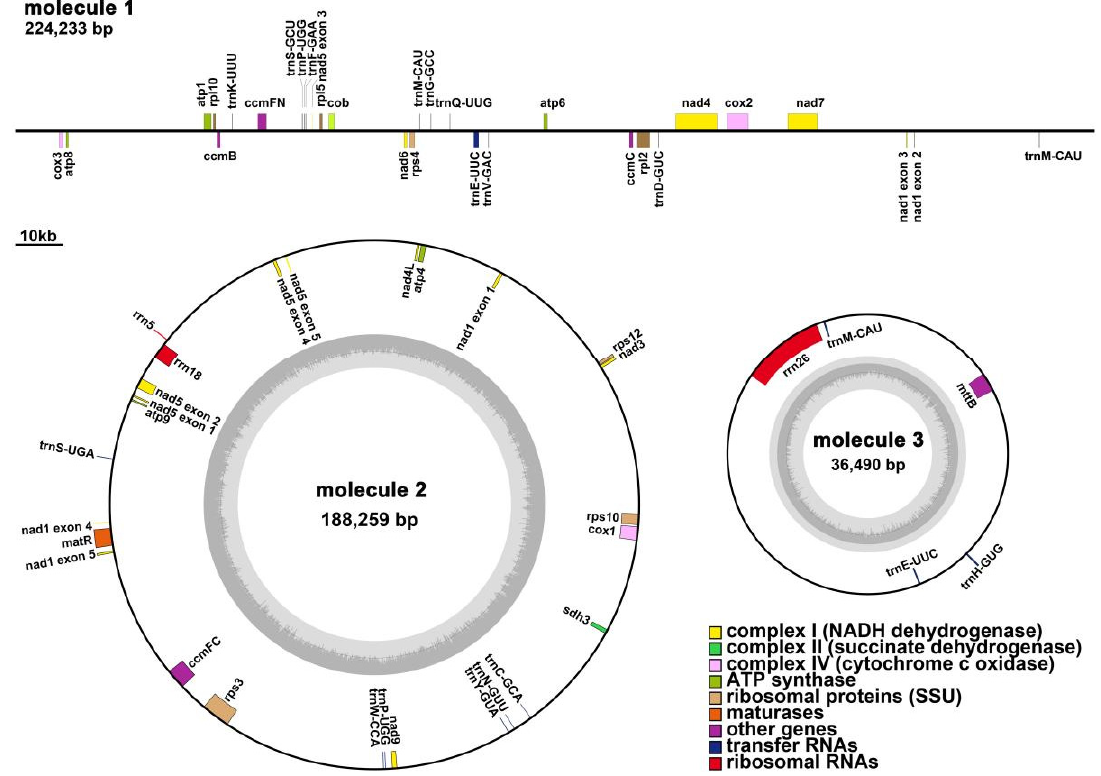
Figure 2. Q. acutissima mitogenome gene map. Genes shown on the outside and inside of the circle are transcribed clockwise and counterclockwise, respectively. The dark gray region in the inner circle depicts GC content.